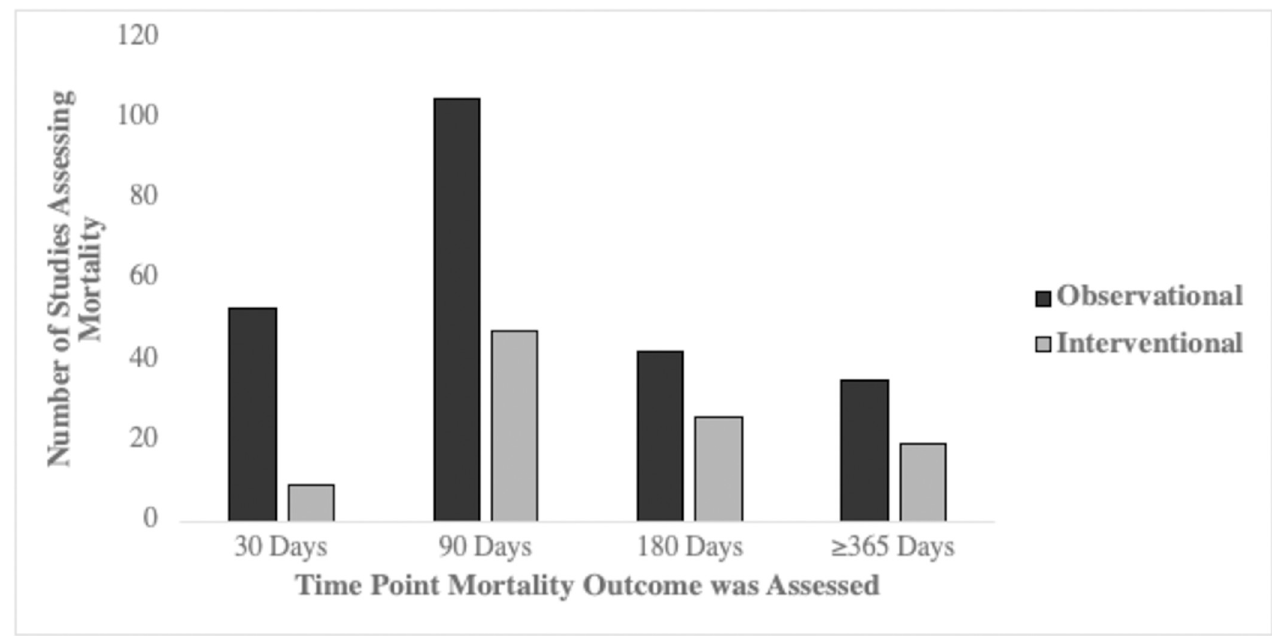
Fig 2. Mortality assessment frequency in observational and interventional trials. The number of studies assessing mortality at four time points for observational (black) and interventional (grey) studies respectively.